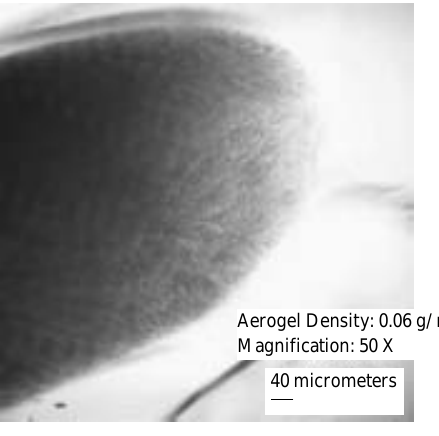
Fig. 9 Naphthalene crystals inside the transparent aerogel